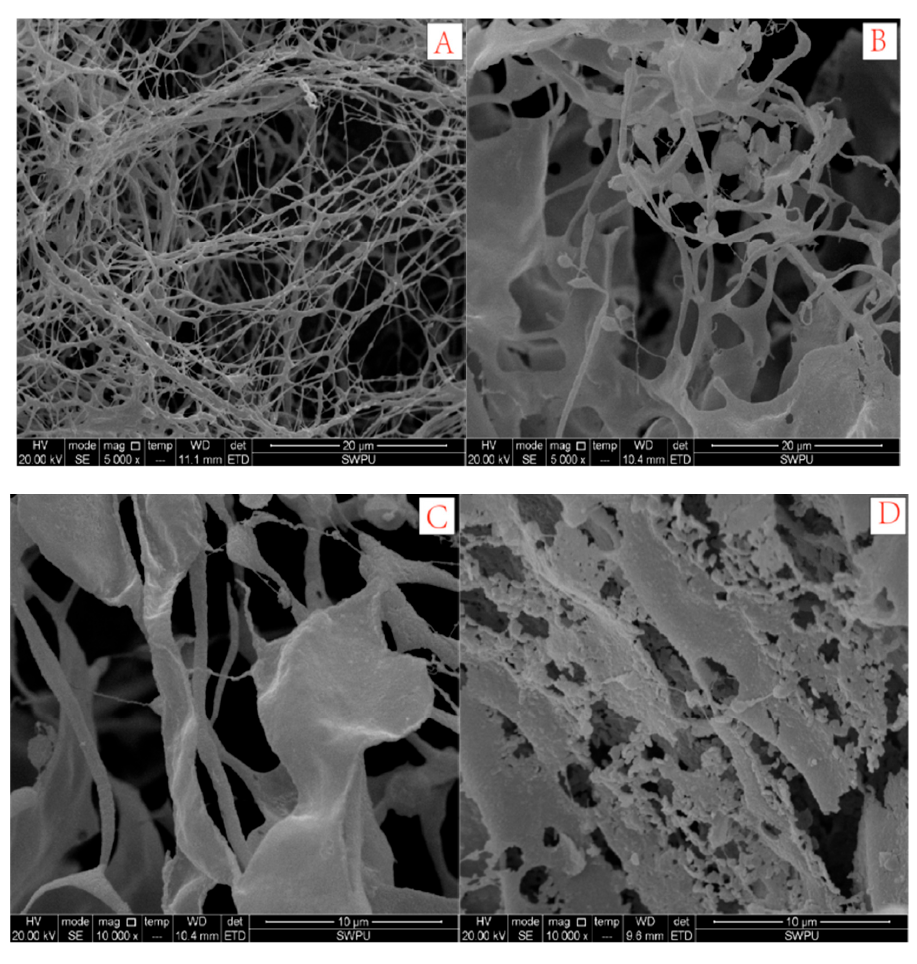
Figure 11. The representative SEM images of a 500 mg/L DiPHAM aqueous solution with different NaCl concentrations. ( A ) 4 × 10 4 mg/L (×5000); ( B ) 8 × 10 4 mg/L (×5000); ( C ) 12 × 10 4 mg/L (×10,000); ( D ) 16 × 10 4 mg/L (×10,000).